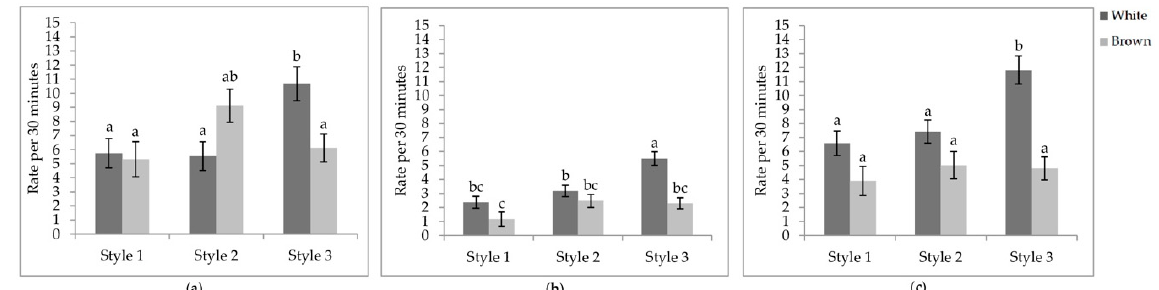
Figure 5. Least square means of the style by colour interactions of locomotory events. Rate per 30 min of ( a ) wing flaps; ( b ) aerial transitions; ( c ) vertical transitions. Visits one, two, and three were when the pullets were 25.9 ± 6.67; 68.0 ± 4.78 days of age; 112.1 ± 3.34 days of age. During visit one, the brooding compartments were closed, whereas during visits two and three, the brooding compartments were open into the litter areas. Error bars represent standard error. a–c Indicate significant differences between means ( p < 0.05).